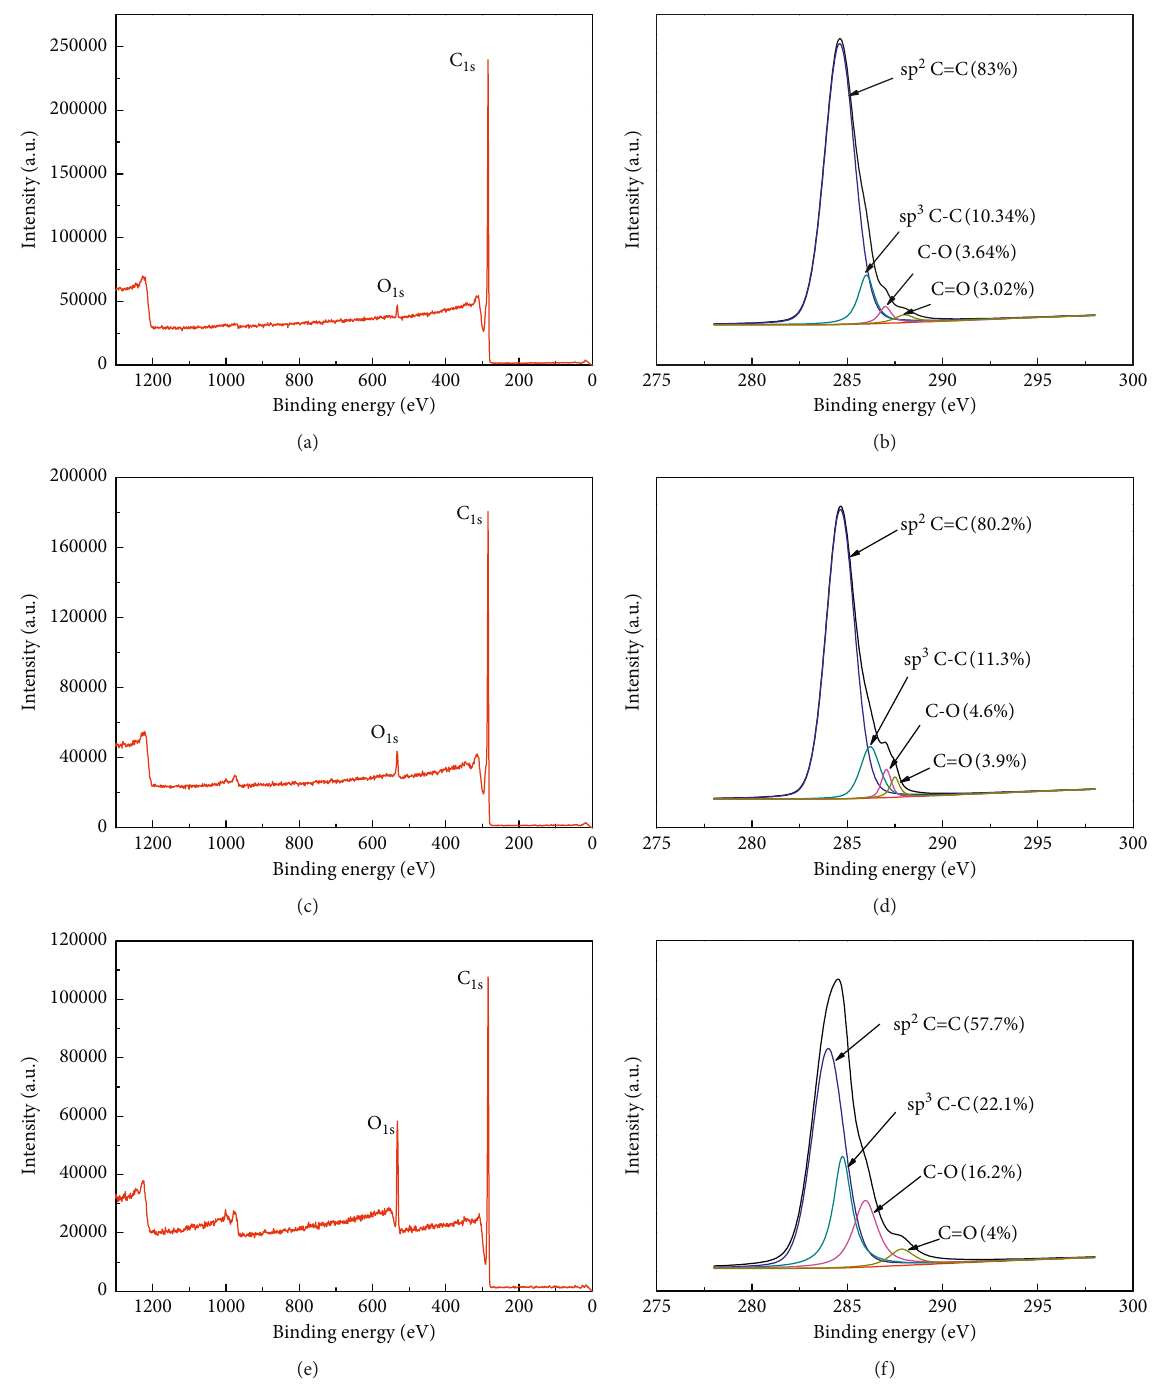
Figure 3: XPS spectra and curve fit of C1s spectra from pristine GF (a, b), MWCNTs/GF (c, d), and hydroxyl MWCNTs/GF (e,